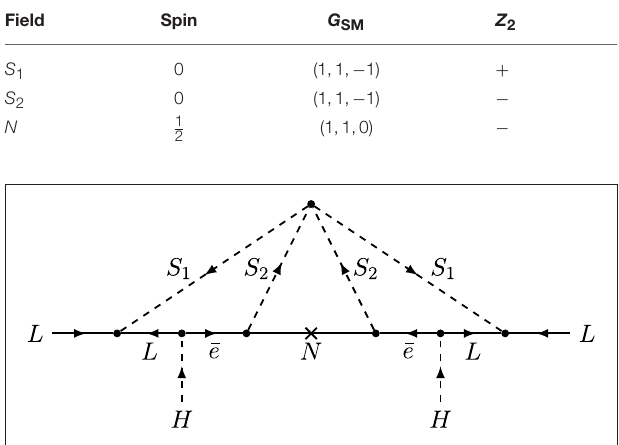
FIGURE 19 | 3-loop neutrino masses generated in the KNT